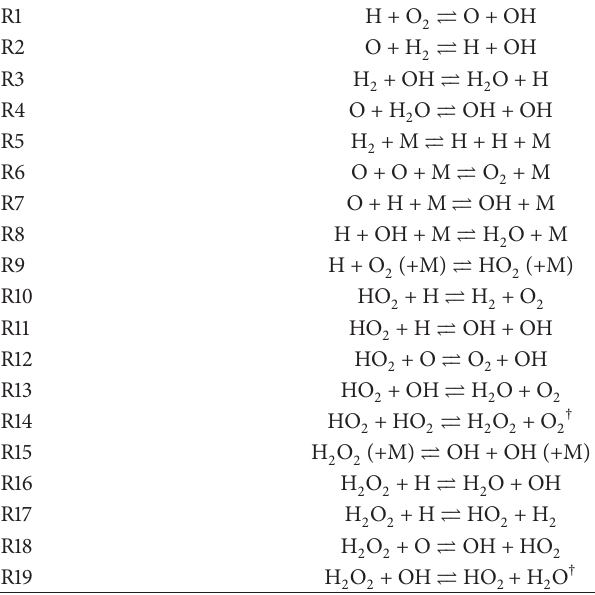
Table 3: Chemical kinetics mechanism of Mueller et al.